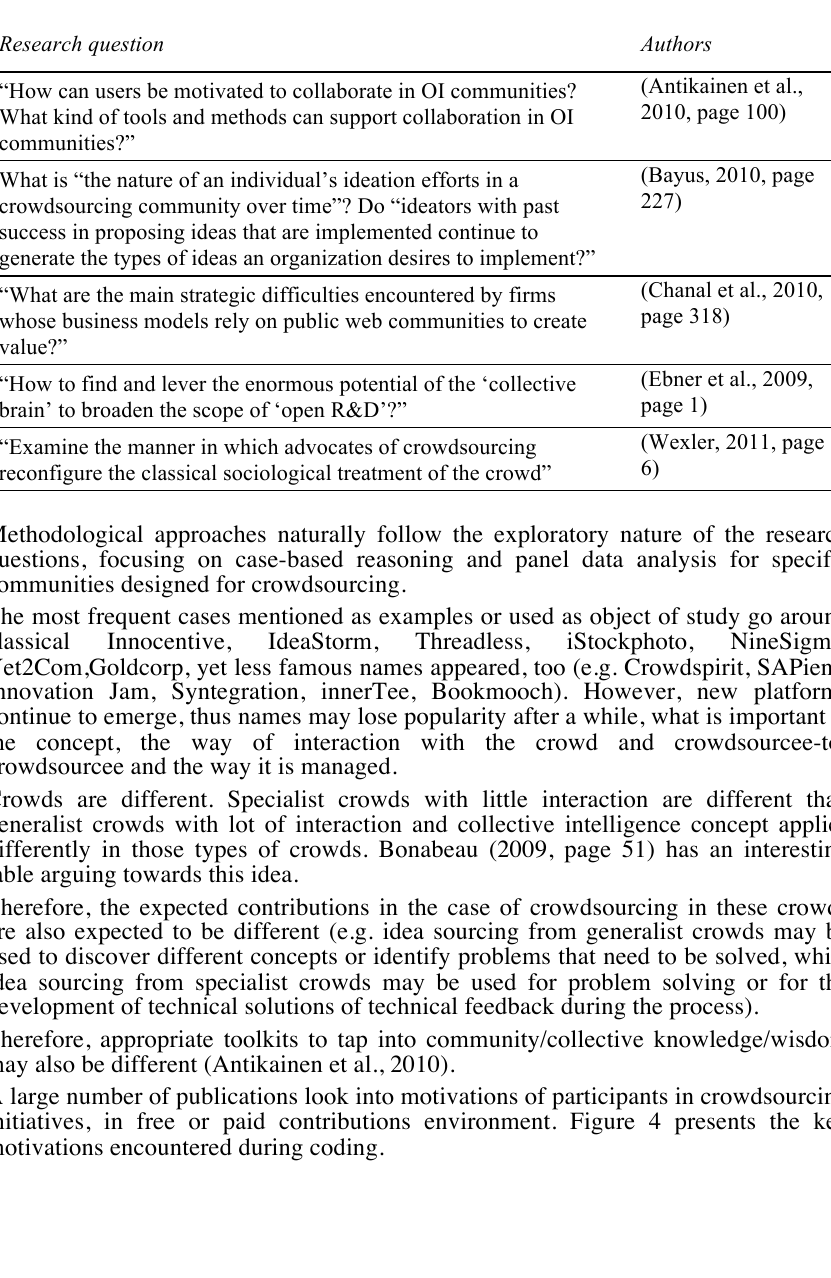
Table 4. Sample of Research Questions on